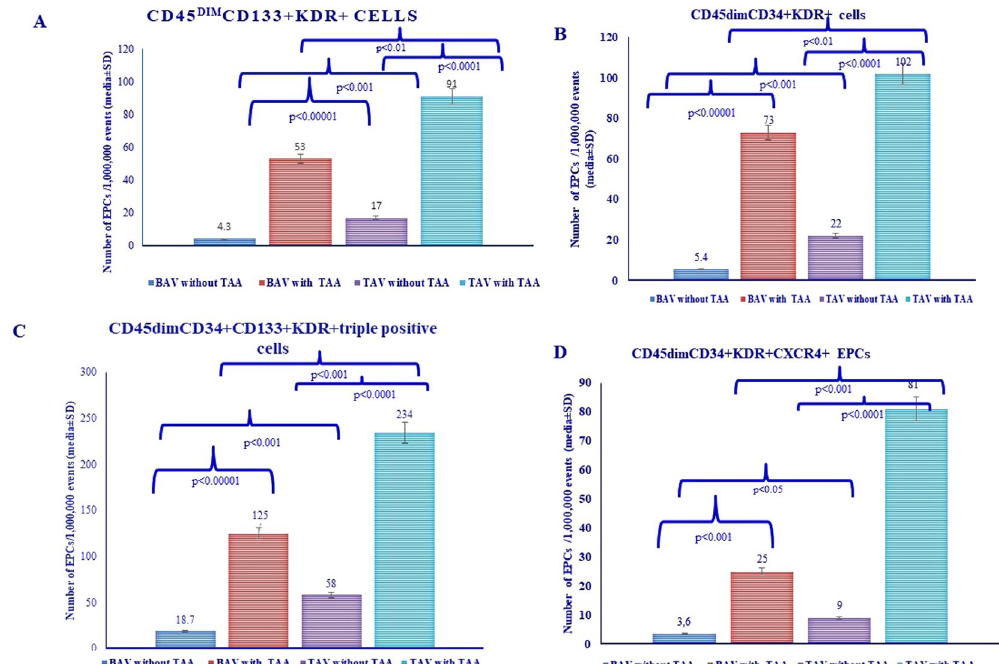
Figure 1. Circulating levels of the four EPC populations detected in peripheral blood from the study population. ( A – D ) Circulating number of different EPC subpopulations was measured in different patient groups. Immunophenotype of the four EPC populations is displayed in the Figure. Of note, population 1 was CD34-negative, whereas population 2 was